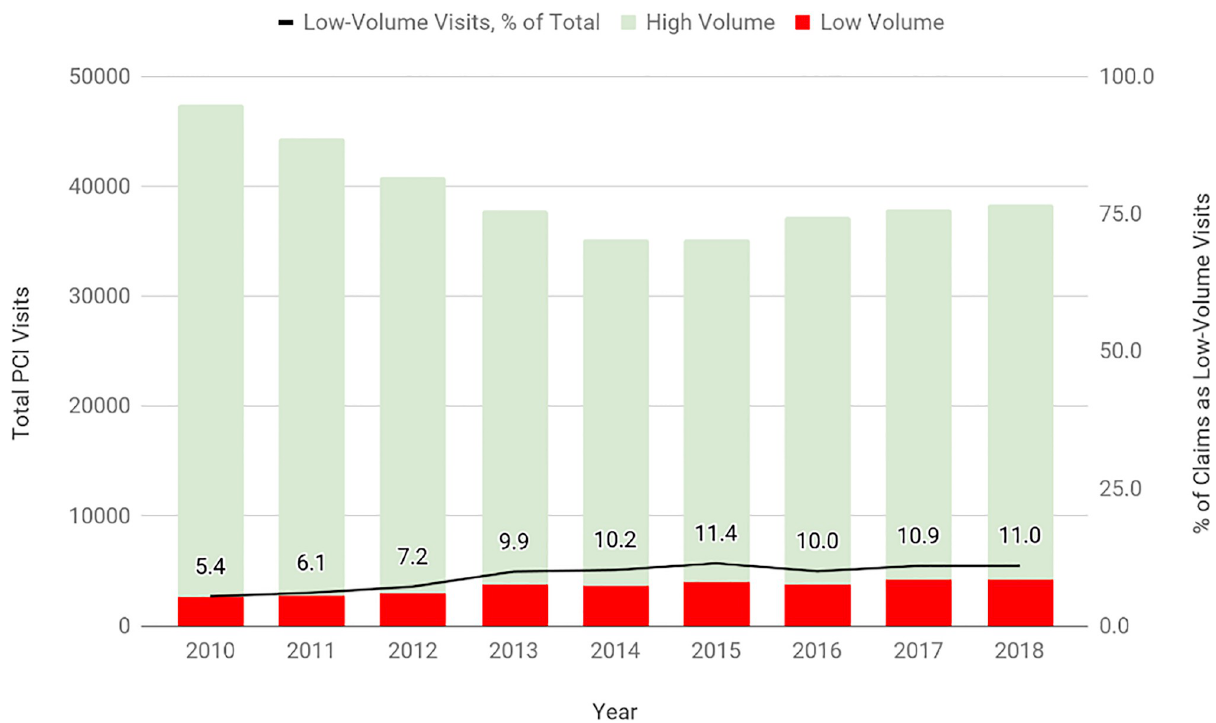
Fig 1. Total PCI volume by year and hospital volume